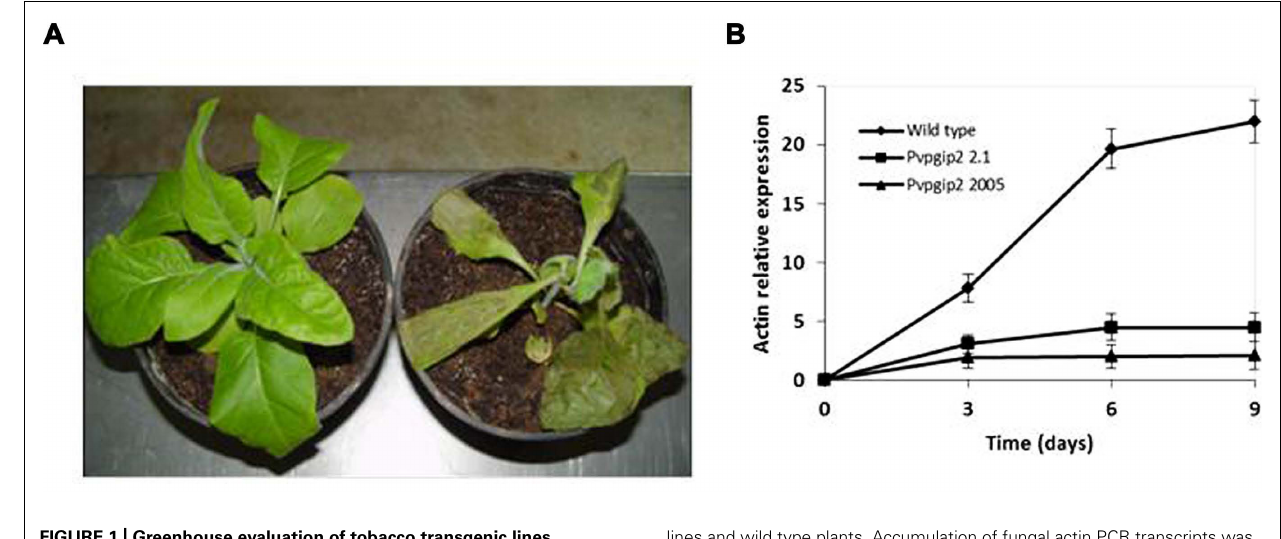
FIGURE 1 | Greenhouse evaluation of tobacco transgenic lines expressing the Pvpgip2 gene inoculated with R. solani . Inoculated transgenic line Pvpgip2 2.1 (A) and wild type tobacco plants at 3 wpi. (B) Quantitative RT-PCR measuring R. solani growth in tobacco transgenic